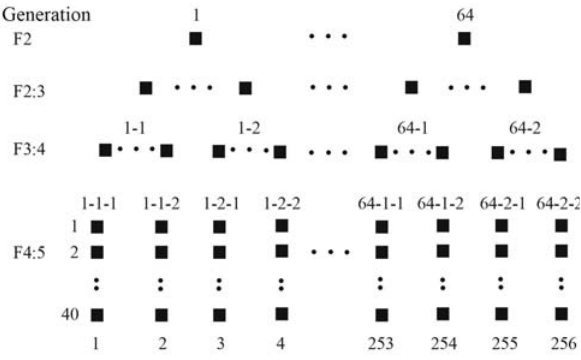
Figure 1 - Scheme of conduction by pedigree